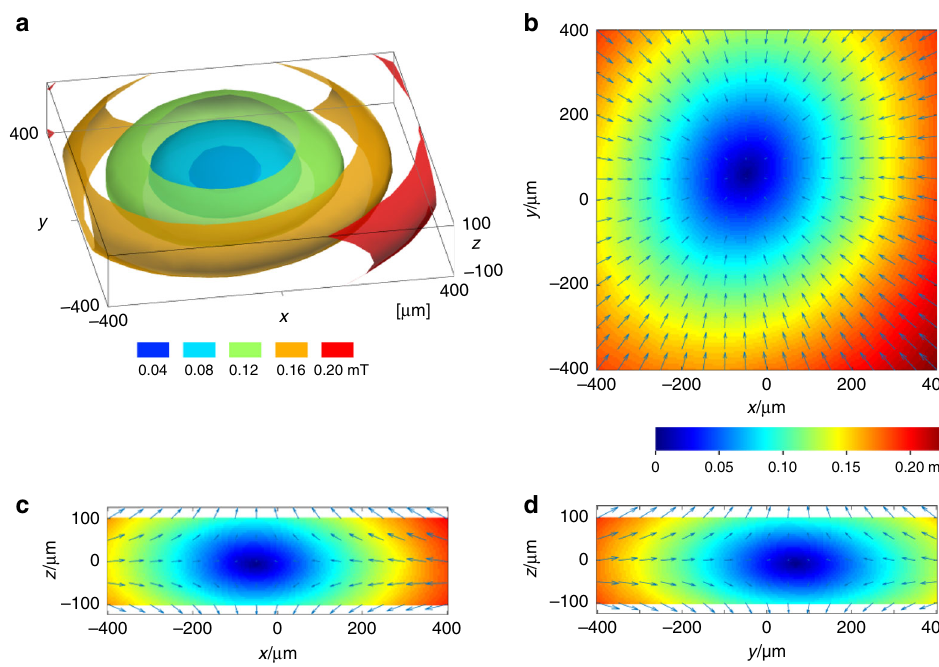
Fig. 2 Experimentally measured three-dimensional (3D) magnetic fi eld distribution in between the FOL and BOL. a 3D magnetic fi eld strength map (shown in color scale) within a 800× 800 × 200 μ m 3 volume between the FOL and BOL. It can be seen that, around the center of the volume, the magnetic fi eld strength is <0.2 mT. b – d Two-dimensional (2D) magnetic fi eld vector maps on b xy ( z = 0), c xz ( y = 0), and d yz ( x = 0) planes. The magnetic fi eld vectors point inwards from the outer region to the center of the volume, and diverge to the ± z -direction at the center